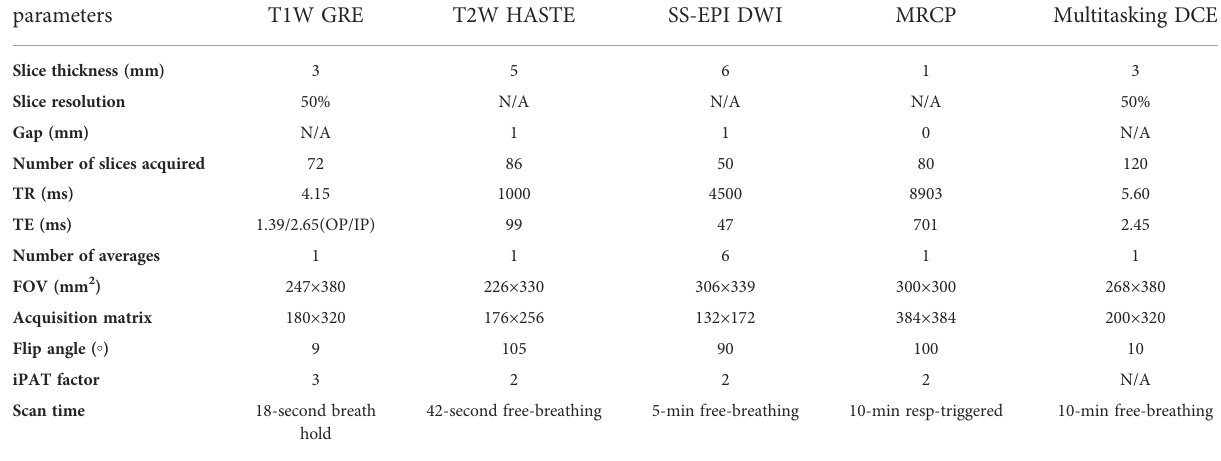
TABLE 1 List of imaging parameters. parameters T1W GRE T2W HASTE SS-EPI